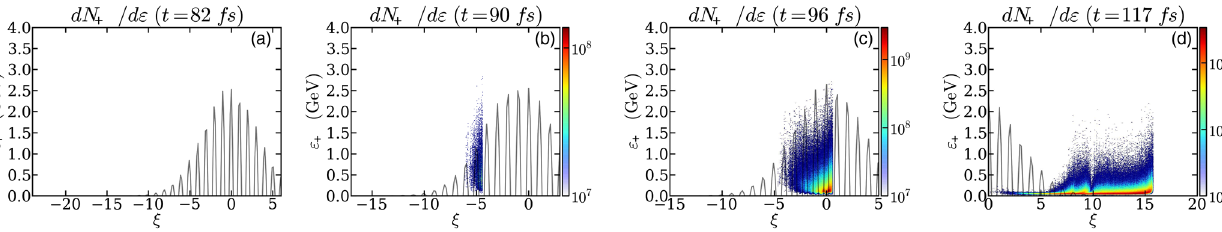
FIG. 7. Positron energy spectra (transversely integrated, in particles per GeV) before (a), during (b,c) and after (d) the laser-beam collision, as a function of the relative distance ξ ¼ ½ x − x p ð t Þ(cid:4) = λ 0 to the laser intensity peak position x p ( λ 0 being the laser wavelength).